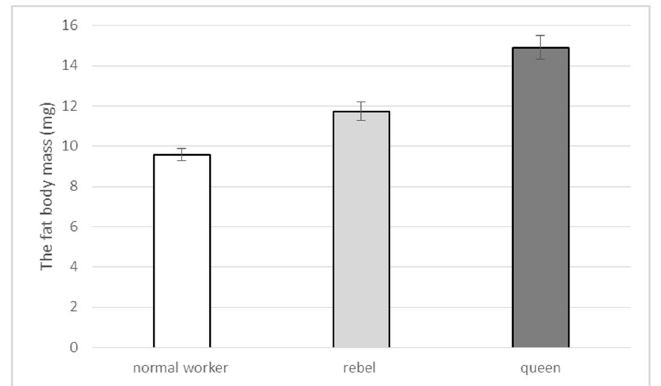
Figure 5. The fat body mass (mg; mean ± SD) of 1-day-old queens, rebel and normal workers. The differences are statistically significant between averages for rebels and normal workers and queens (Two-way ANOVA with multiple comparison testing using the post hoc Tukey HSD test; colony F 2,171 = 2.3, p = 0.22; castes/sub-caste F 2,4 = 4378.6, p < 0.001, post-hoc between each groups: p < 0.001; colony*castes/sub-caste F 4,171 = 0.4, p = 0.787; no. of queens = 60; no. of rebels = 60; no. of normal workers =